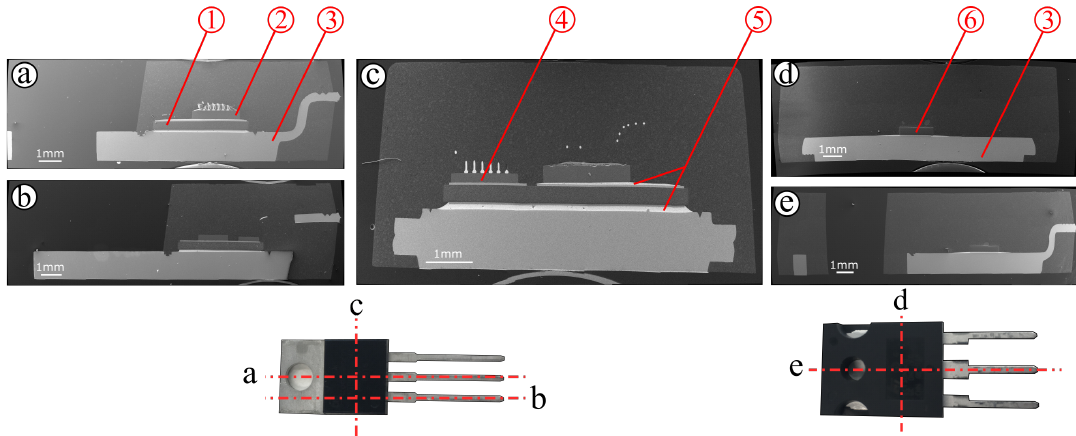
Figure 6. Scanning electron microscopy cross section images of ( a – c ) a cascode GaN device and ( d , e ) a SiC device with (1) the ceramic substrate, (2) the GaN-on-Si die, (3) the baseplate, (4) the anti-parallel diode, (5) the solder interconnection, and (6) the SiC die.